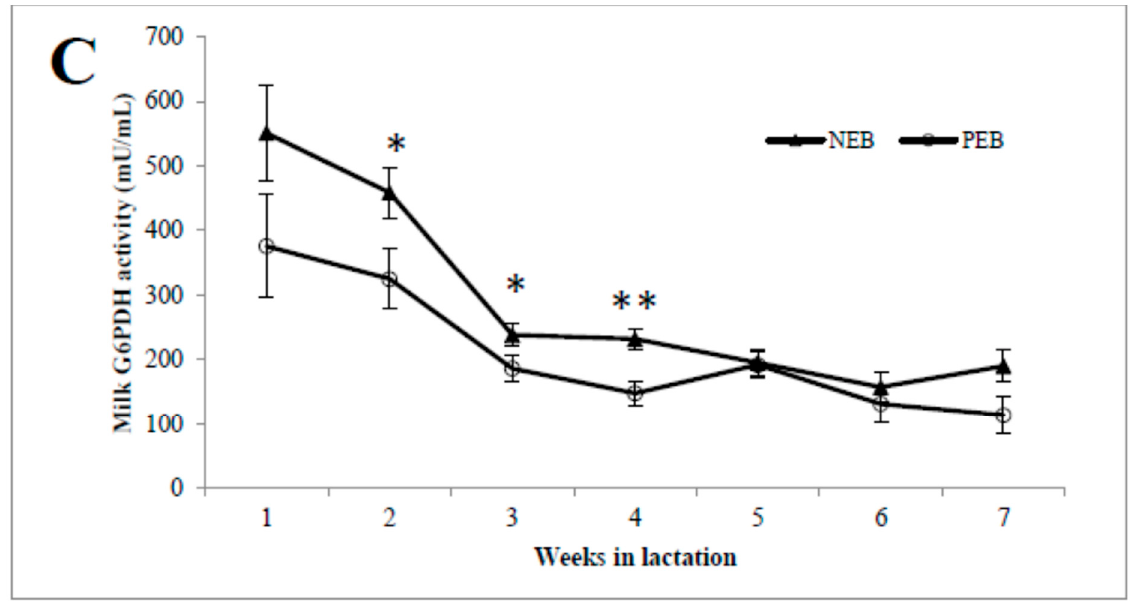
Figure 1. Milk samples from cows that were classified retrospectively as being in negative energy balance (NEB, n = 11) or positive energy balance (PEB, n = 13), according to their mean energy balance during the first 21 DIM, were examined for their concentrations of milk glucose-6-phosphate (G6P; A ), and glucose ( B ) as well as G6P dehydrogenase (G6PDH; C ) activity for 5–45 DIM. * p ≤ 0.05; ** p ≤ 0.01. Table 4. Correlations between energy balance (EB) and milk metabolites, oxidative stress markers, and FA composition during the first 45 d in